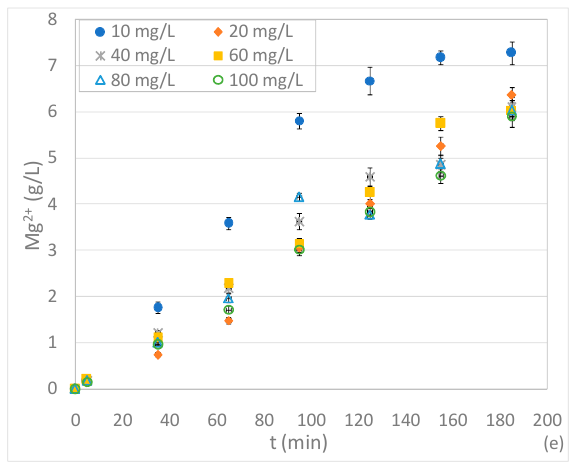
Figure 3. Concentrations of N-NO 3 − ( a ), N-NO 2 − ( b ), N-NH 4+ ( c ), Δ N ( d ) and Mg 2+ ( e ) during the tests carried out at pH 3, with 2 g of Mg 0 , varying the initial N-NO 3 − concentration between 10 and 100 mg/L.